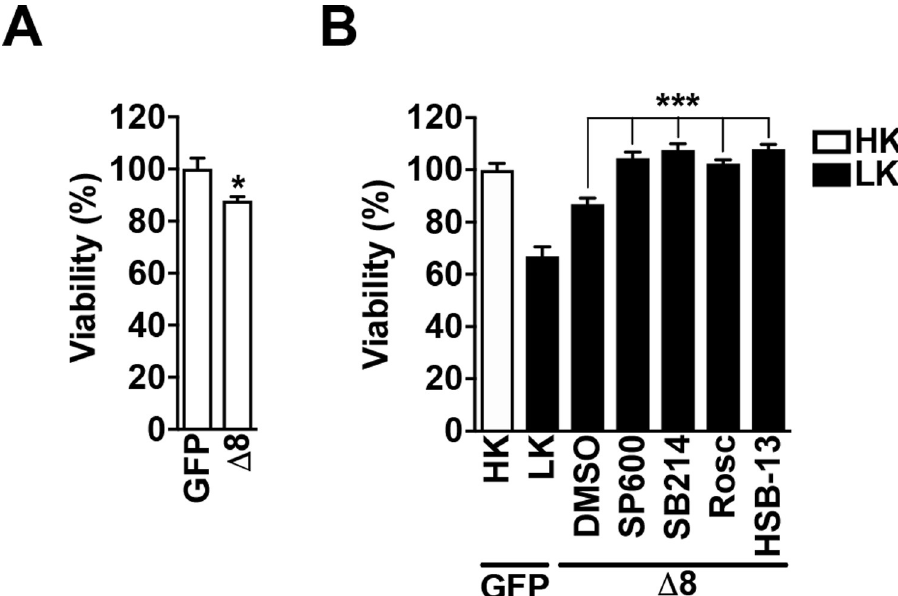
Fig 6. Loss of the Δ 8 region is toxic to neurons. A. Expression of Δ 8 induced death in otherwise healthy neurons. GFP or Δ 8 were expressed into CGNs and then treated with HK media for 24 h ( � p < 0.05; n = 3). B. CGNs were transfected with GFP or Δ 8. Neurons were then treated with either HK, LK, or LK media supplemented with the following for 24 h: DMSO, SP600125 (JNK inhibitor), Roscovitine (CDK inhibitor), SB216763 (GSK3 inhibitor), HSB- 13 ( ��� p < 0.001; n =